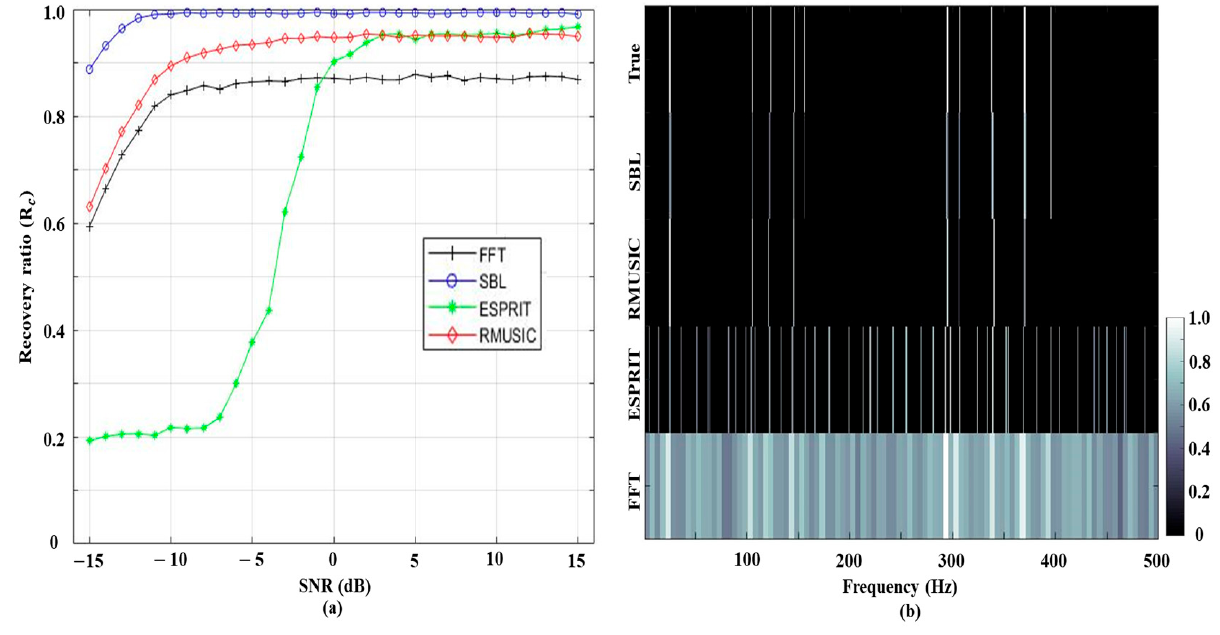
Figure 2. ( a ) The recovery ratios for FFT, SBL, ESPRIT, and RMUSIC according to the SNRs. Ten frequency components are included in each trial; ( b ) the detection results at the lowest SNR of − 15 dB, which qualitatively displays the detected frequency components from the schemes.